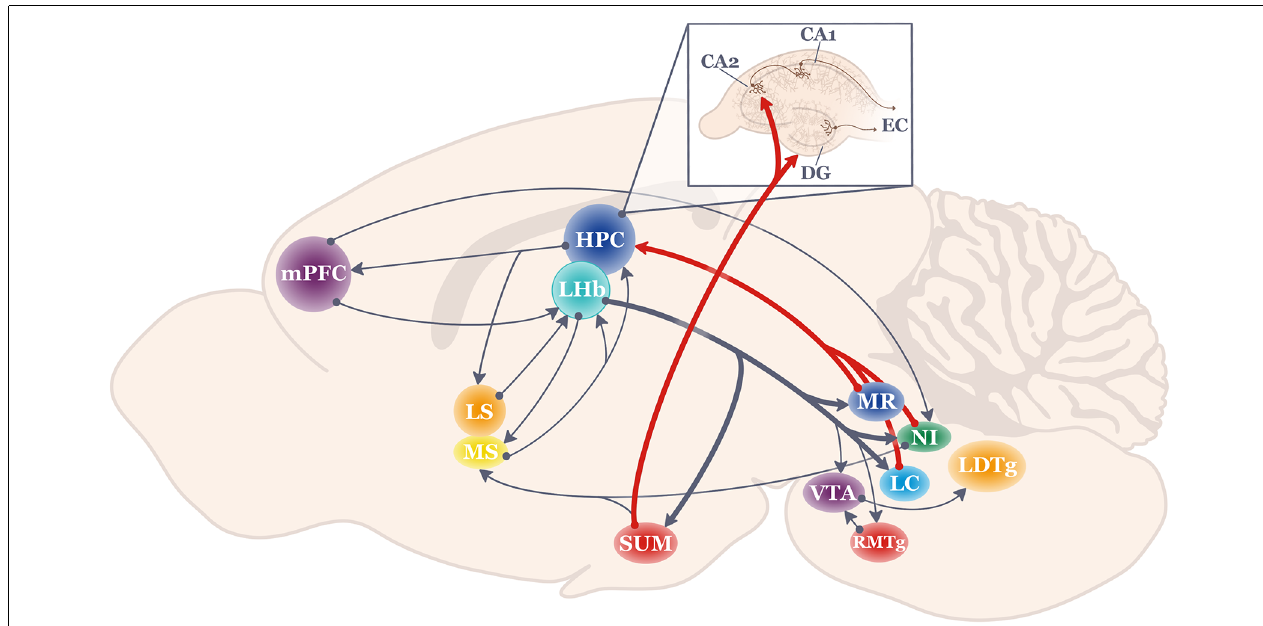
FIGURE 1 | Schematic of the anatomical projections to and from the lateral habenula (LHb; shown in teal). Thick lines highlight LHb projections most strongly related to hippocampal function. HPC, hippocampus; LC, locus coeruleus; LDTg, lateral dorsal tegmentum; LHb, lateral habenula; LS, lateral septum; mPFC, medial prefrontal cortex; MR, medial raphe; MS, medial septum; NI, nucleus incertus; RMTg, rostromedial tegmentum; SUM, supramammillary nucleus; VTA, ventral tegmental